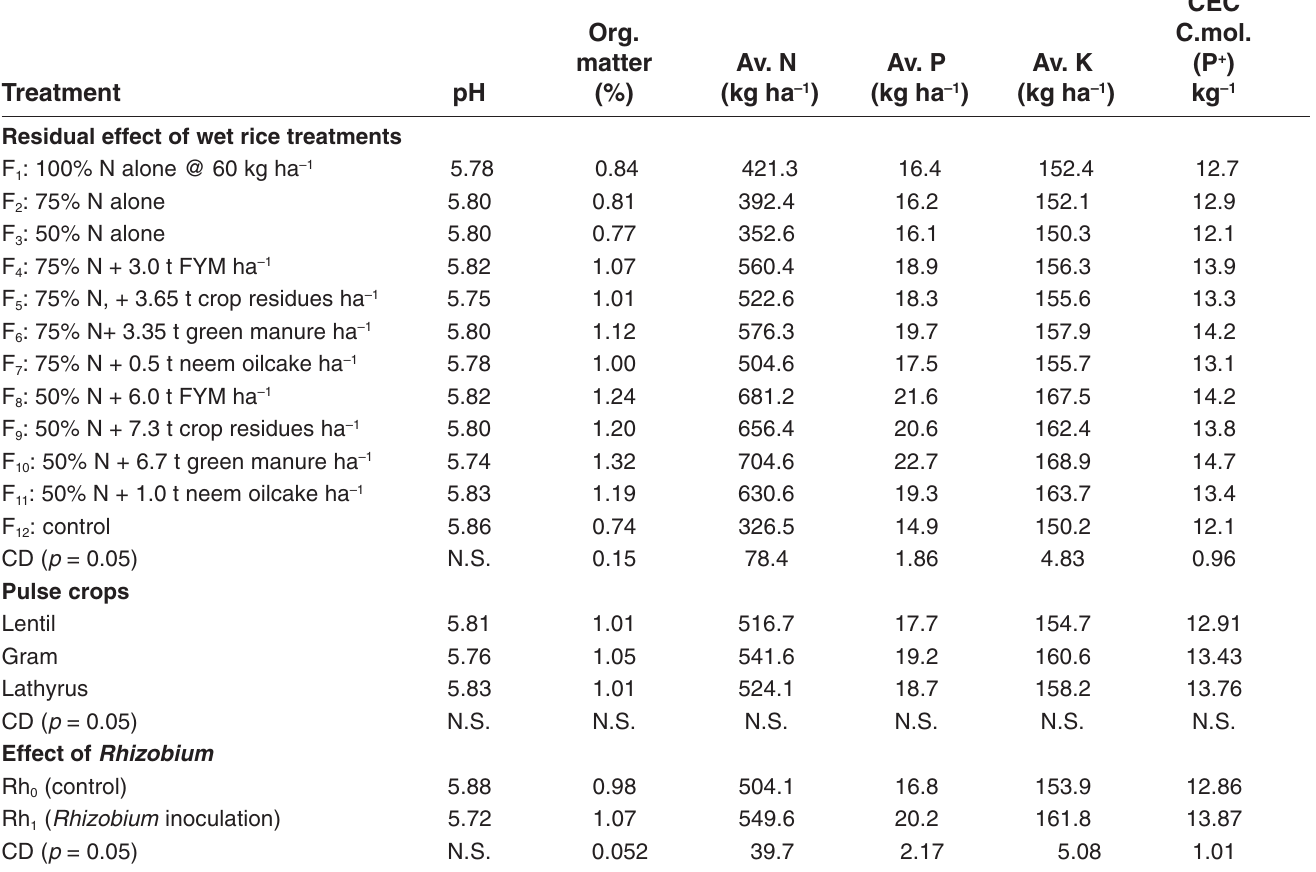
Soil Fertility Status After Harvesting of Last Pulse Crops